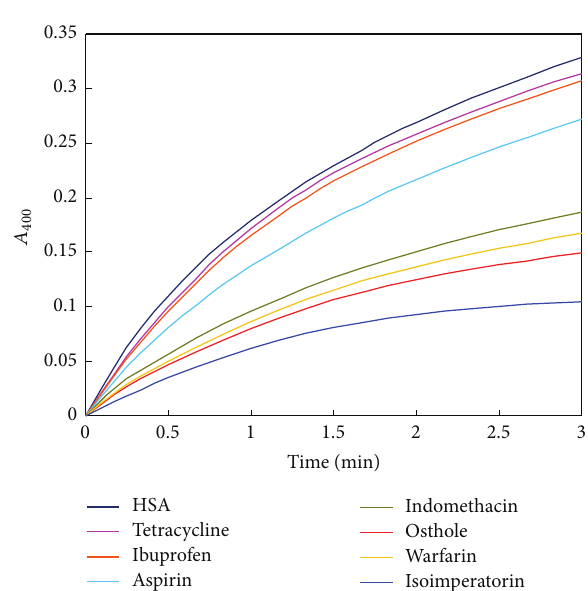
Figure 12: 4-Nitrophenyl acetate esterase activity of HSA in the absence and presence of tetracycline and ibuprofen (site II), war- farin, aspirin, indomethacin, and osthole (site I), and isoimperatorin (site I). Final concentration of protein, pNPA, and drugs were 15, 250, and 250 𝜇 M, respectively. For interpretation of references to color in this figure legend, the reader is referred to the web version of this